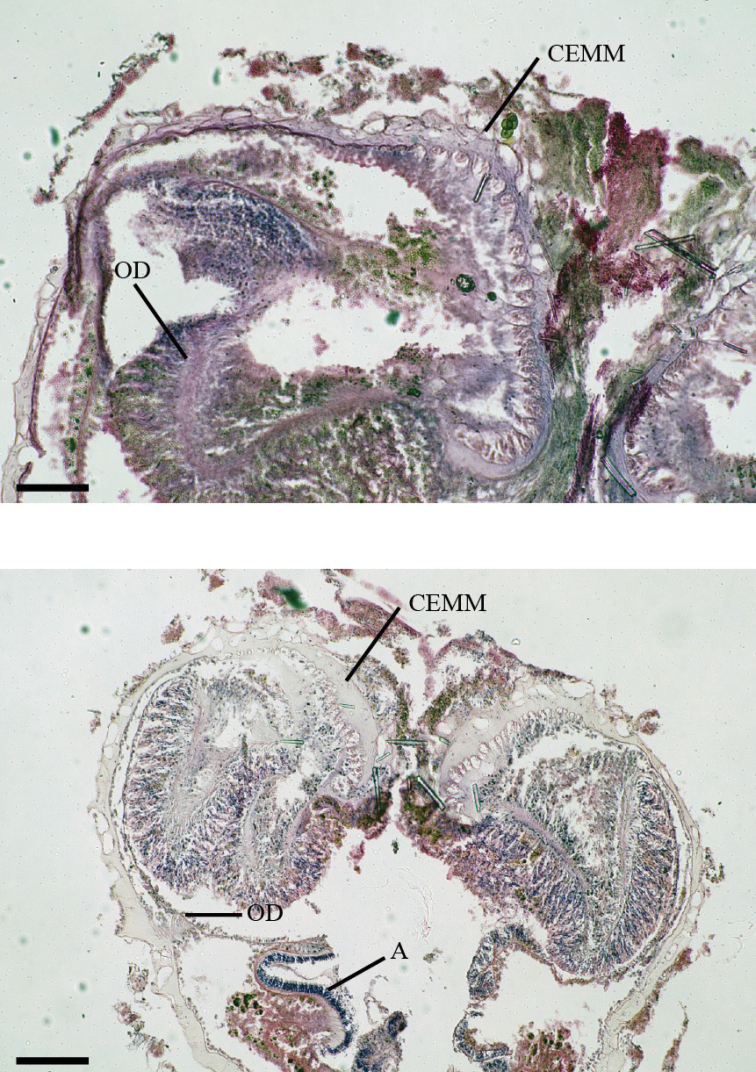
Images of histological section of Antipathozoanthus species. a longitudinal section of A.
remengesaui sp. n. b longitudinal section of A.
cavernus sp. n.. Abbreviations: (CEMM) cteniform endodermal marginal muscle, (OD) oral disk, (A) actinopharynx. Scale bars: a 200 µm, b 50 µm.